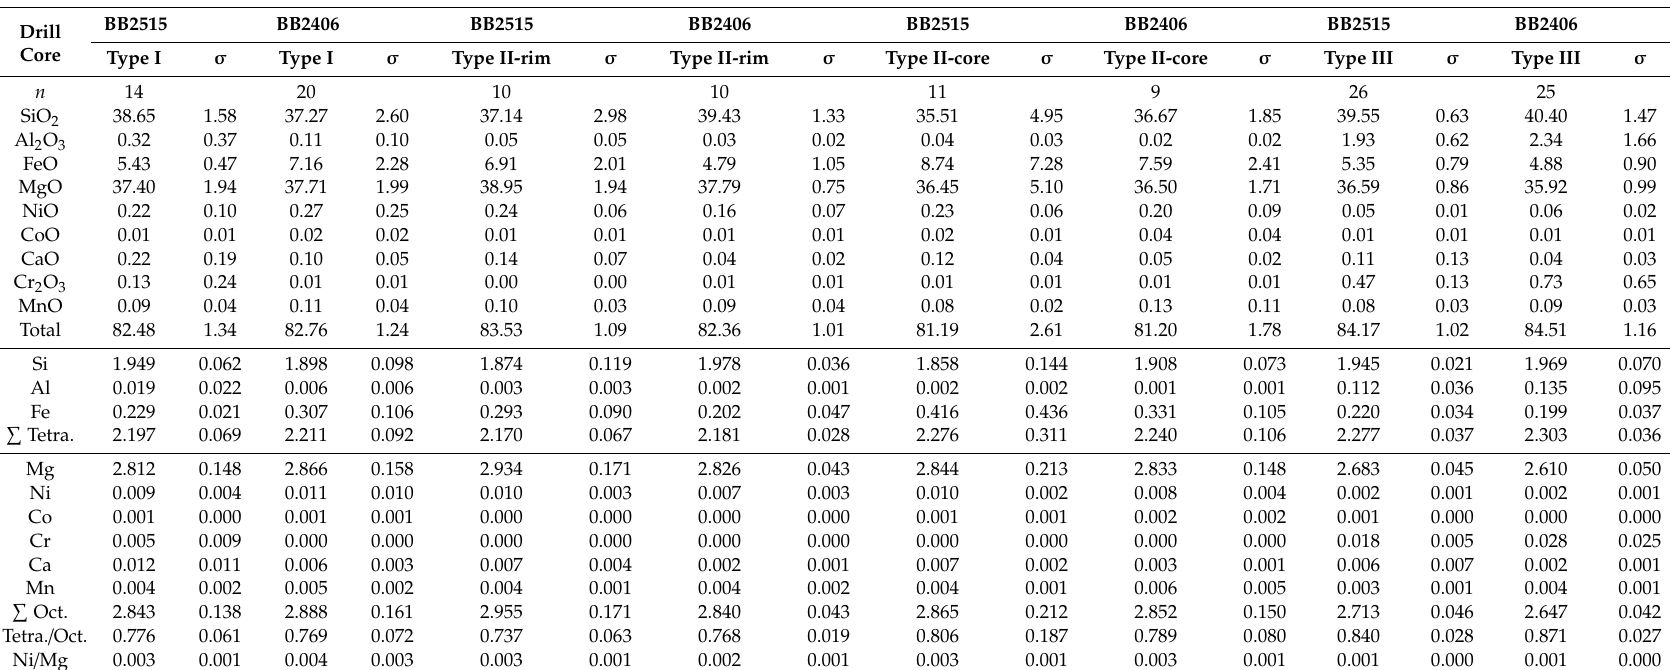
Table 2. Average chemical compositions (wt%) and structural formula (apfu) of the di ff erent vein serpentines in the